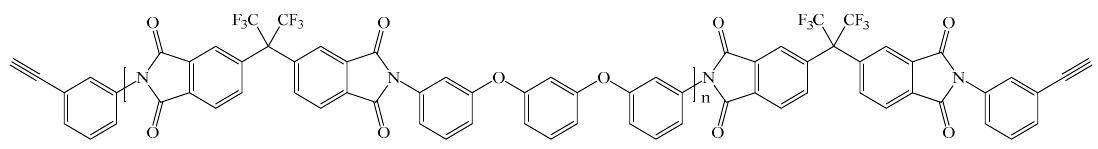
Figure 17. Chemical structure of Thermid FA-700.